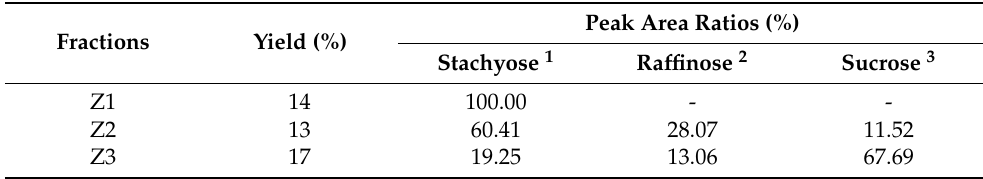
Figure 2. The HPLC chromatogram of SBOS, glucose, sucrose, raffinose, and stachyose ( a ); the HPLC chromatogram of three sub-fractions Z1, Z2, and Z3 ( b ). Table 1. Peak area ratios of stachyose, raffinose, sucrose in Z1-Z3 components and monosaccharide composition.